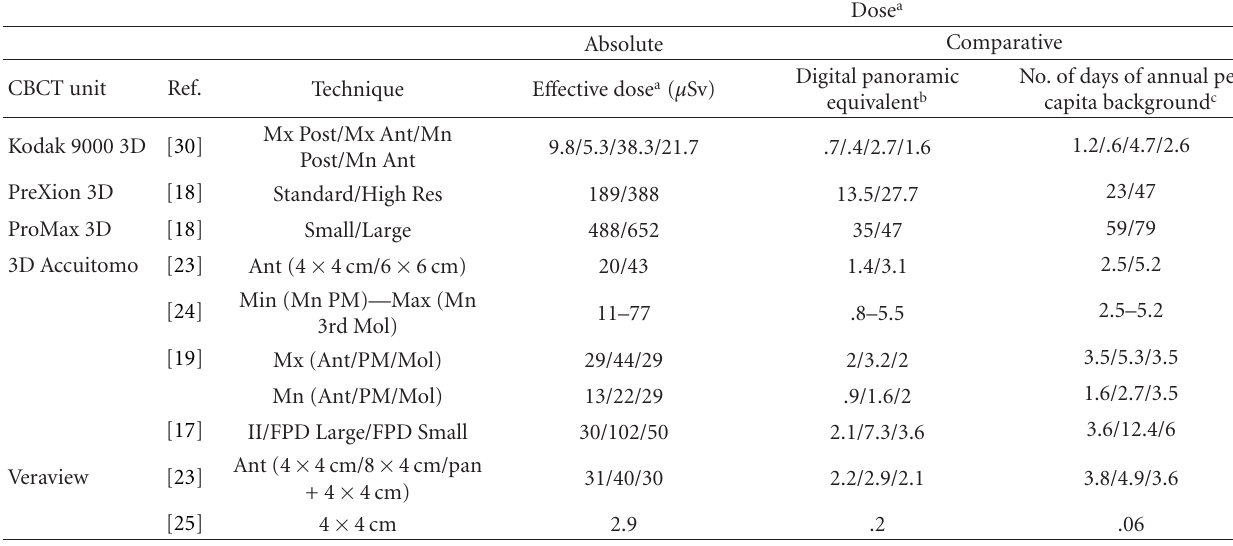
Dose a Absolute Comparative